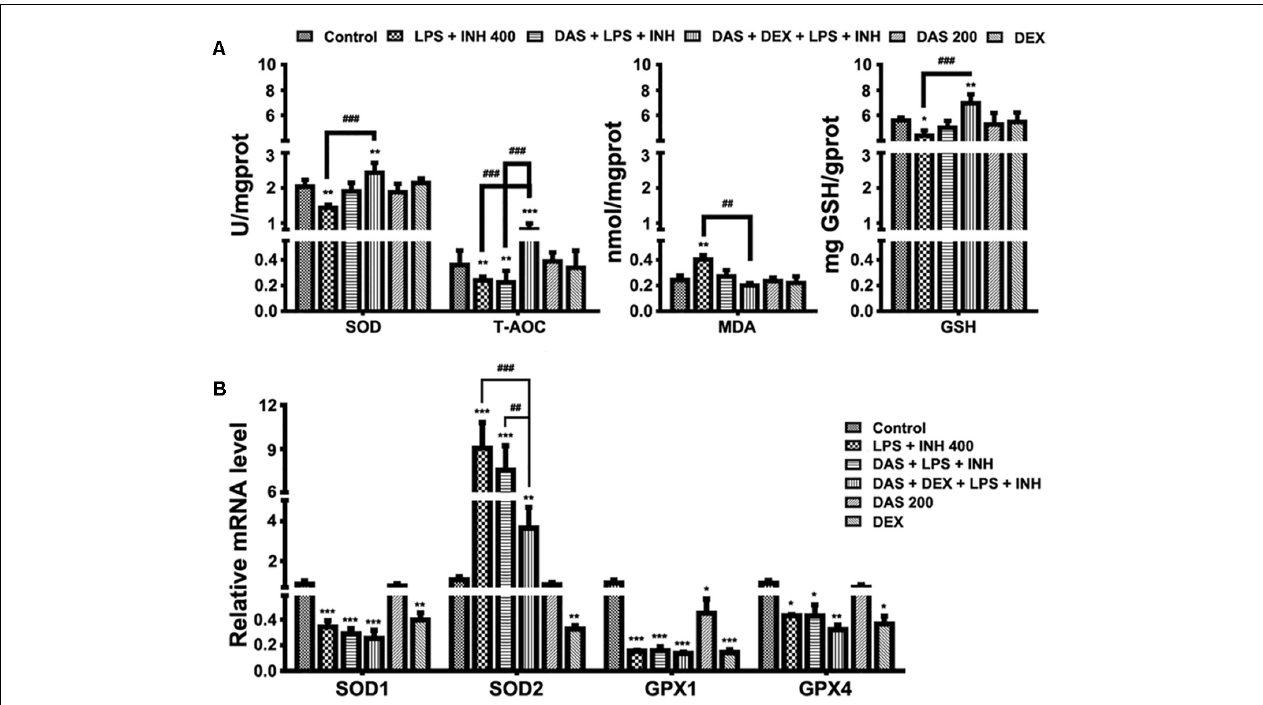
FIGURE 4 | Variations in oxidative stress and hepatic antioxidant defense mechanisms. (A) Changes in SOD, T-AOC, MDA, and GSH levels were measured by their respective kits. (B) Antioxidant gene expressions after drugs administration. Data are represented as mean ± SD, n = 7 for each bar. ∗ P < 0.05, ∗∗ P <